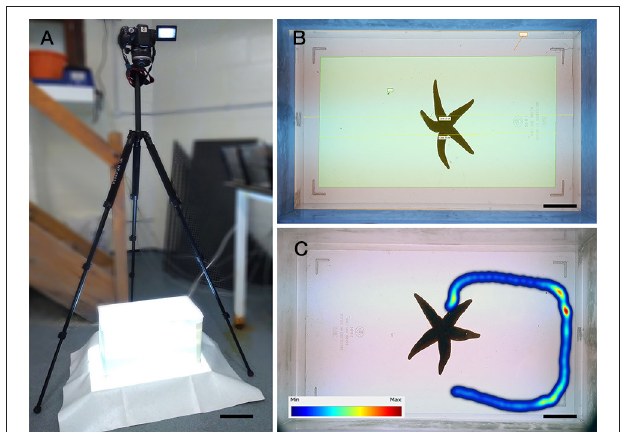
FIGURE 2 | Recording locomotor activity of the starfish A. rubens in a laboratory setting. (A) Photograph of the experimental set-up, with a camera positioned above a Plexiglas aquarium (37 × 19.8 × 25cm) containing 7l of seawater, with all the walls covered with white plastic and situated on top of a lightbox to enhance video contrast, which facilitated detection of the experimental animal by the video-tracking software Ethovision XT1. (B) Photograph showing the software arena settings, with the area defined as the floor in yellow (length of 33cm) and a starfish positioned in the center of the aquarium at the beginning of an experiment. (C) Photograph showing tracking of a starfish using Ethovision XT1, with the color scale bar representing the time spent in one position (minimum in blue to maximum in red). Scale bars: (A) : 13.1cm; (B) : 4.7cm; (C) : 4.7cm.